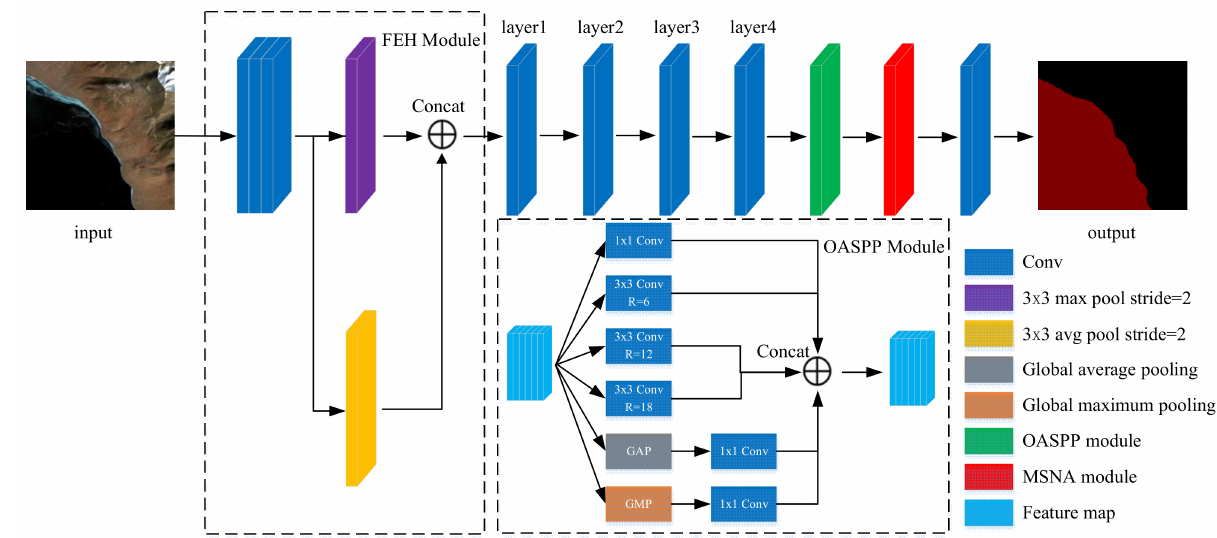
Figure 2. The structure of MSNANet. Inside the dotted box are the structures of FEH and OASPP,